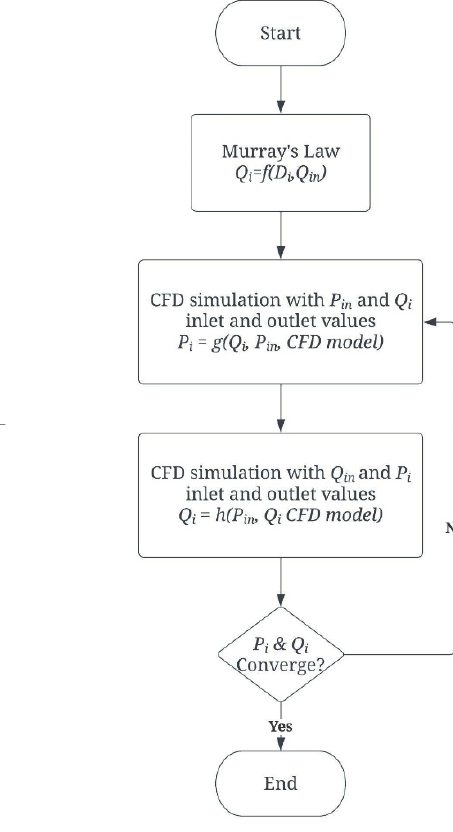
Figure 2. Algorithm for the outflow boundary conditions. Table 1. Workflow procedure of rapid iterative